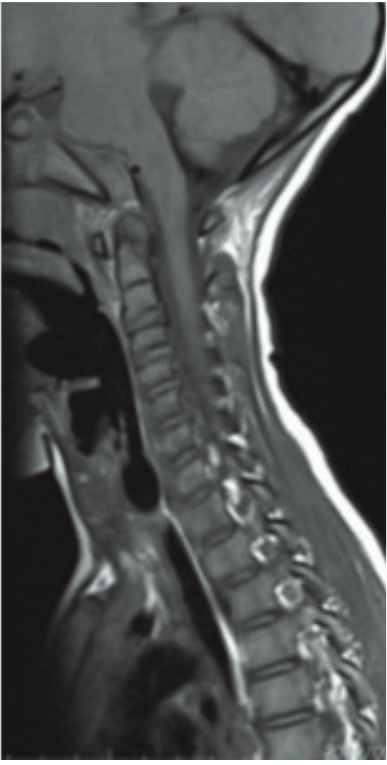
Fig 5. Midline sagittal T1-weighted MRI at the CCJ. Fig. 6. Midline sagittal T2-weighted MRI at the